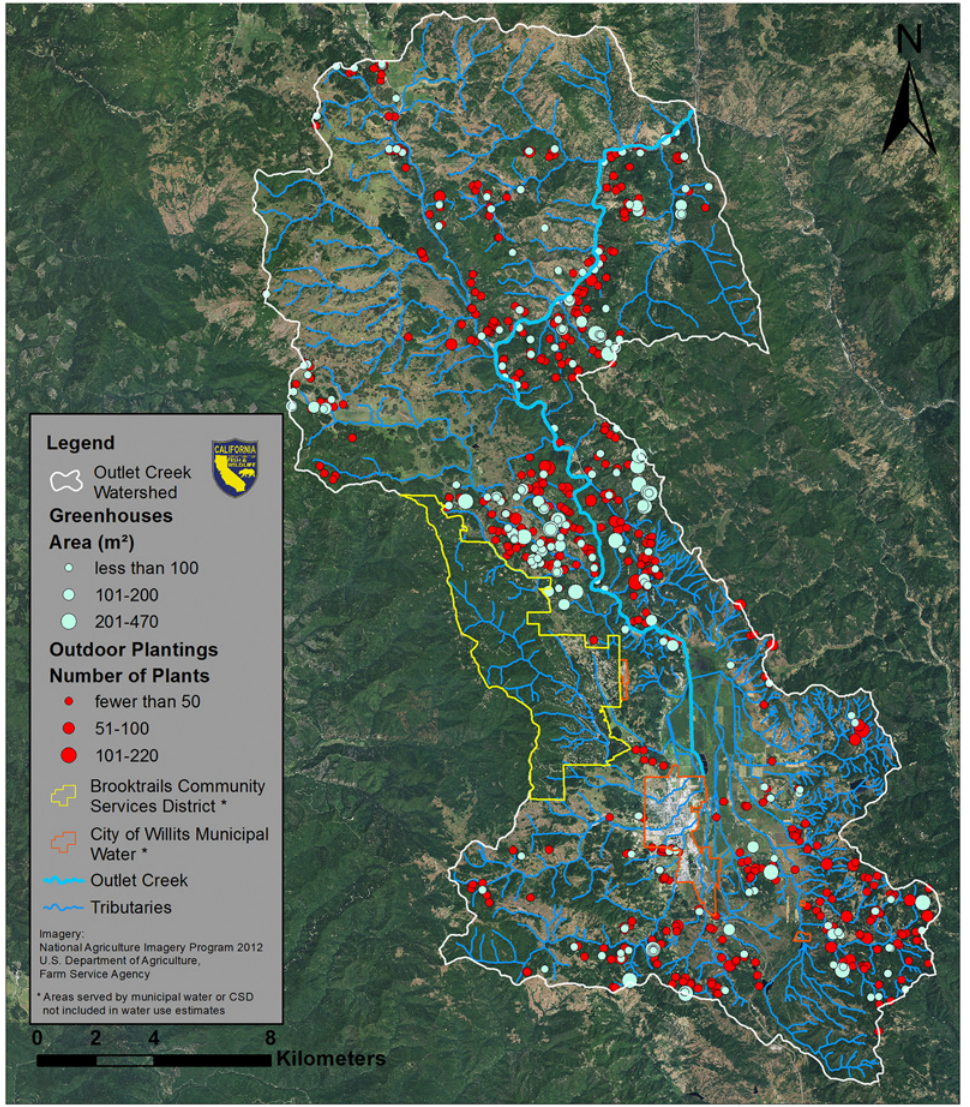
Fig 4. Outlet Creek Watershed. Outdoor marijuana plantings are marked in red and greenhouses are marked in light